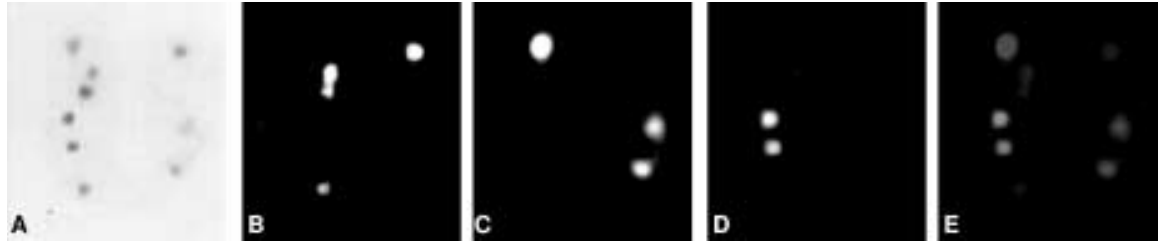
Fig. 3. Spectral analysis of one nucleus of a T24 cell without counterstaining from a triple-color ISH experiment using specific probes for centromeres of chromosome 1, 7, and 15 visualized with DAB, NF and TMB, respectively. The three different colors of the nine ISH signals are difficult to discern in (A) the raw microscopic image before spectral analysis. After spectral decomposition each dye is detected and represented in a gray-scale image (B) DAB, (C) NF and (D) TMB. Merging the three detection images in RGB pseudo-colors results in (E) a color classification image showing DAB in blue, NF in red and TMB in